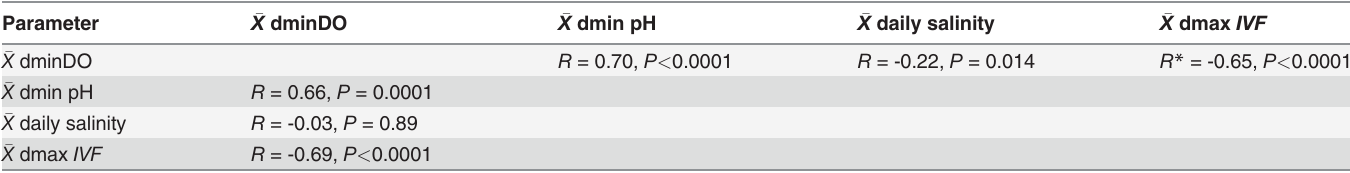
Pearson correlations are reported except as noted with an * for Spearman Rank Correlation results. Values arranged horizontally use each year at a site as an independent value; results listed vertically combine multiple years at each